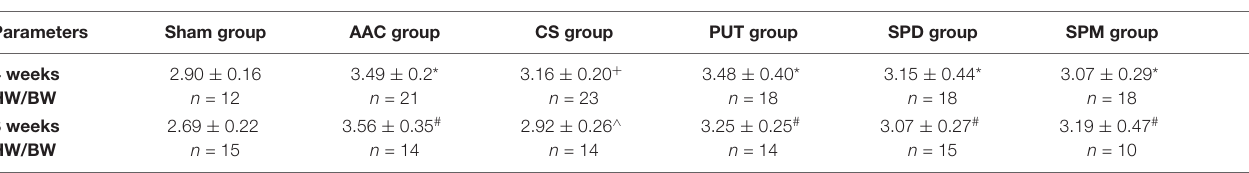
TABLE 1 | Heart-weight to body-weight (HW/BW)